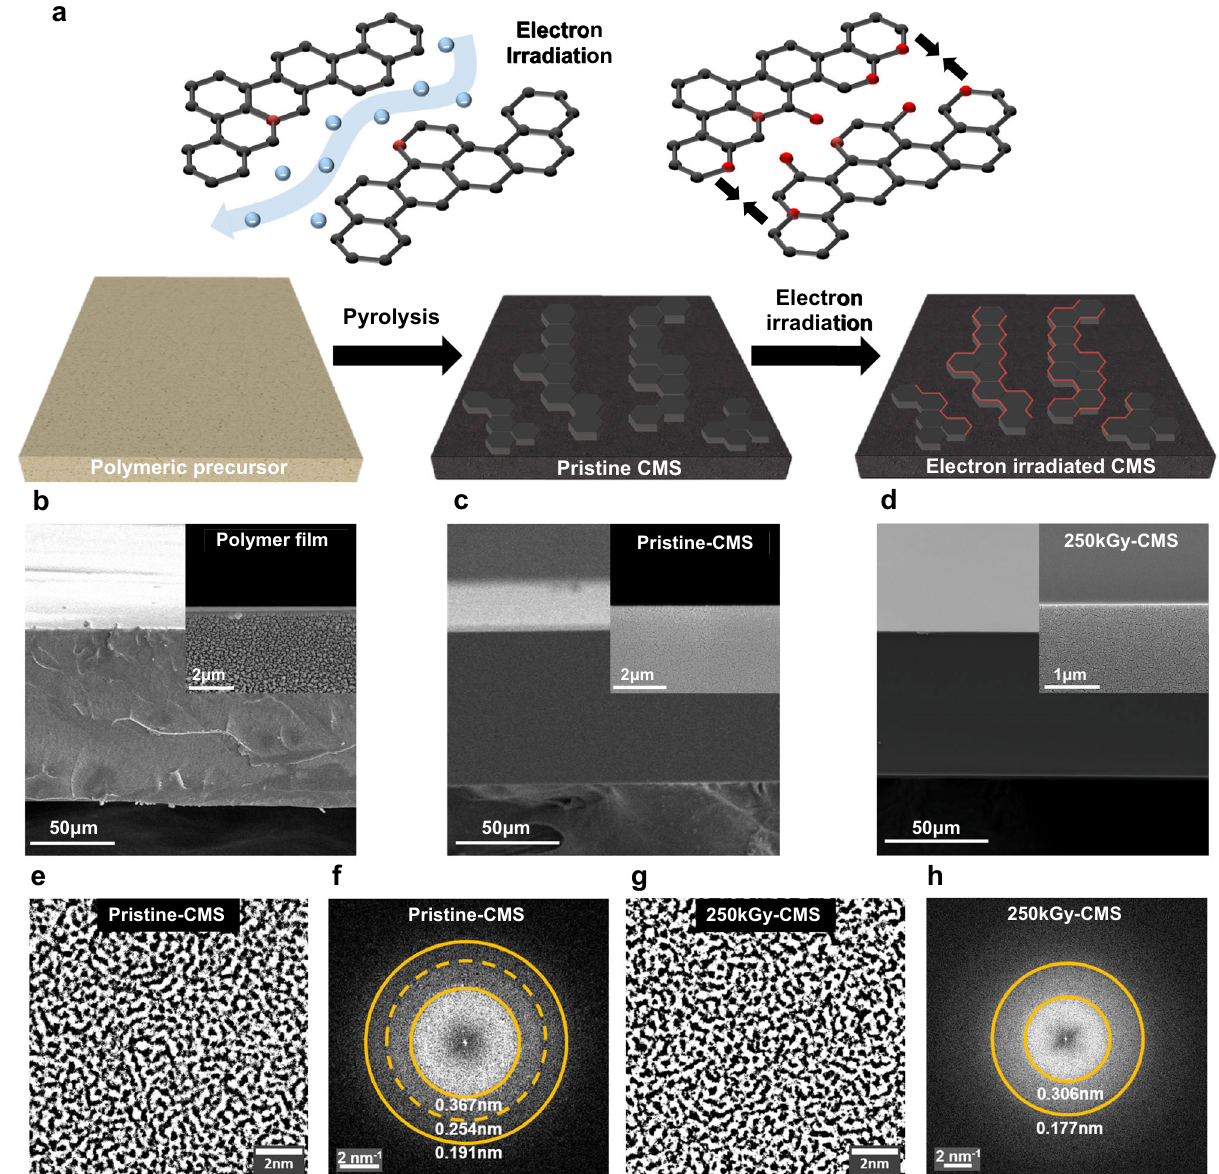
Fig. 1 | Preparation of electron-irradiated CMS membranes and morphology characterization. a Schematic description of polymeric precursor pyrolysis for fabricating CMS membranes with electron irradiation with microstructure tuning. b – d Scanning electron microscopy (SEM) cross-section images and their high